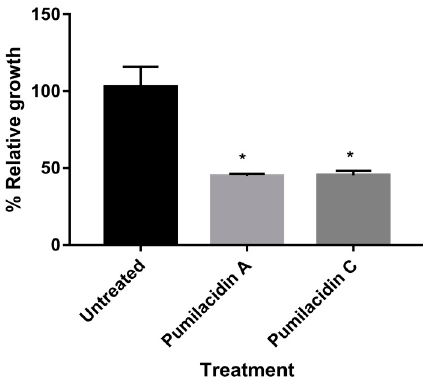
Figure 3. Effect of pumilacidins on the proliferation of P. falciparum . Plasmodium parasites were cultured in the presence of pumilacidins A and C at 10 μ M for 24 h. The proliferation of pumilacidin-treated parasites was measured by flow cytometry quantifying their DNA content with Hoechst 33342 staining. Data represent the means ± SEM of two independent observations performed in triplicate. * p < 0.05.